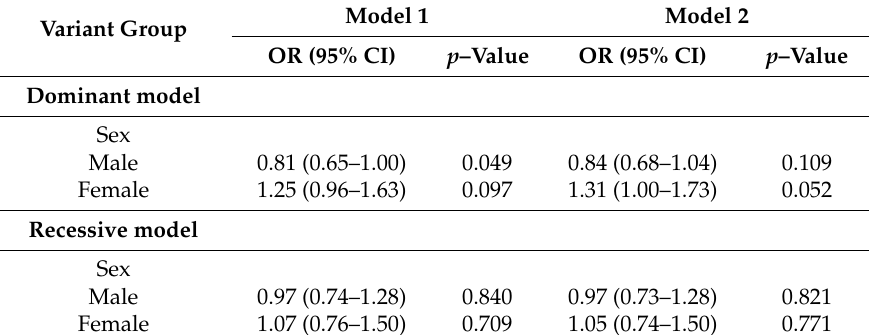
Table 4. rs2910164 genotype was not associated with ischemic stroke incidence according to